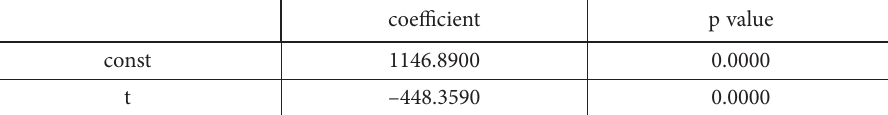
Table 5. The trend model of the bankruptcy in Poland in the years 2005–2016 (source: Own